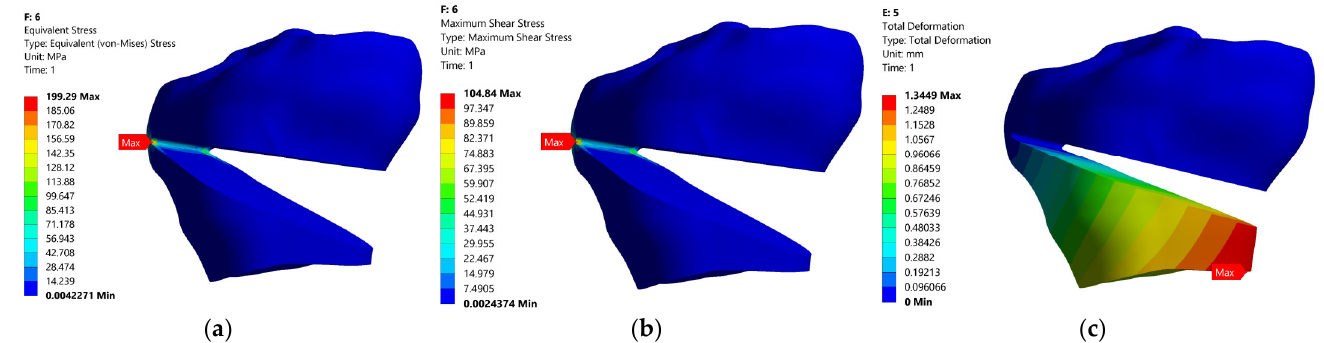
Figure 11. Static FEM analysis for model with code 6: ( a )—equivalent stress, ( b )—shear stress, ( c )—displacement.